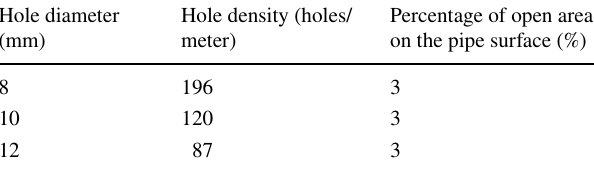
Table 6 Determining holes per meter Hole diameter (mm)